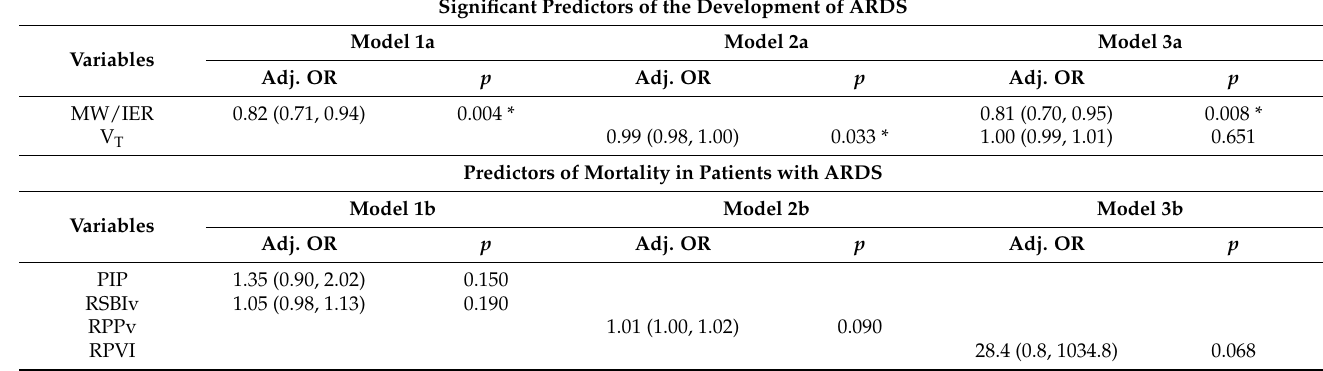
Table 4. Firth logistic regression analyses with stepwise elimination procedure for predicting the development of ARDS and mortality in patients with